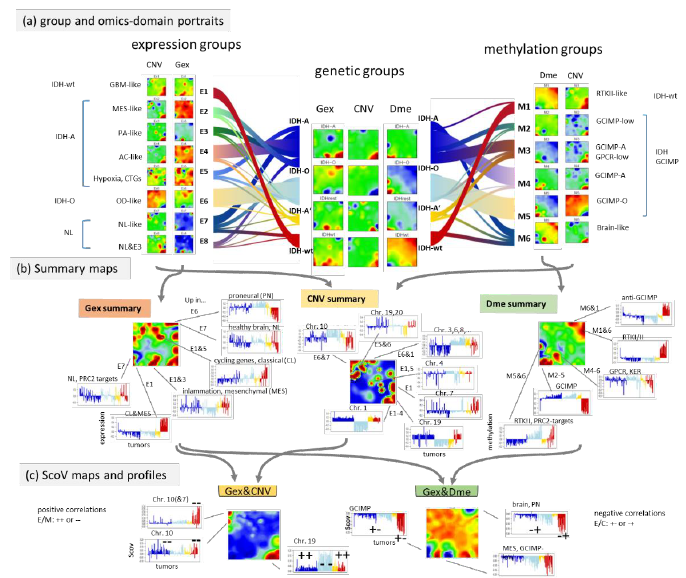
Figure 7. Stratification of genetic groups into expression (E-) and methylation (M-) subtypes defined previously [35]. ( a ) The flow diagrams visualize the distribution of the E- and M groups across the G groups. The group portraits reveal a high diversity of Gex and Dme patterns not fully resolved in the genetic groups (see text). The full gallery of individual tumour portraits is shown in Figure A1. ( b ) The spot summary maps provide an overview of the major spots due to high omics score values (Gex, Dme and CNV) in the respective group portraits. Their omics score profiles were sorted and coloured according to the genetic groups. ( c ) ScoV portraits of the Gex versus-CNV type are dominated by red spots due to positive correlations between gene expression and CNV aberrations while Gex Dme ScoV portraits show predominantly blue spots due to negative correlations between gene expression and DNA methylation. Positive correlations reflect either combined up- (++) or down- ( −− ), regulation while negative correlations split into up-/down- (+ − for Gex_UP and Dme_DN) or down-/up- ( − +) combinations.